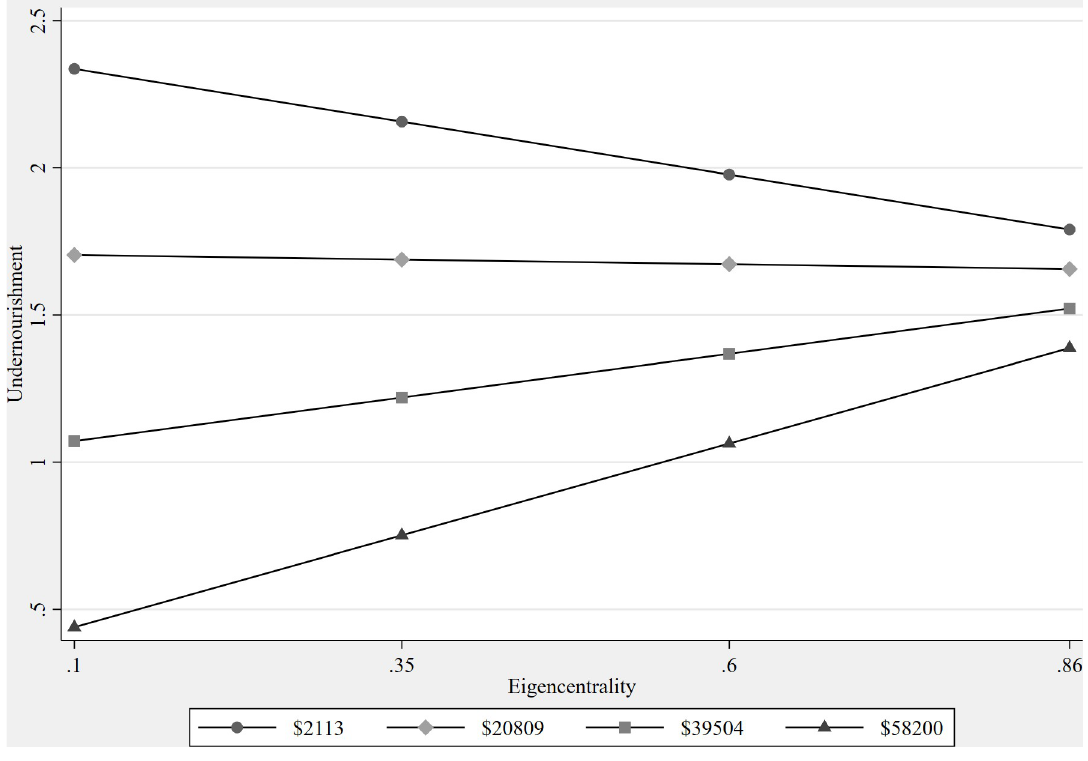
Fig 7. Predicted